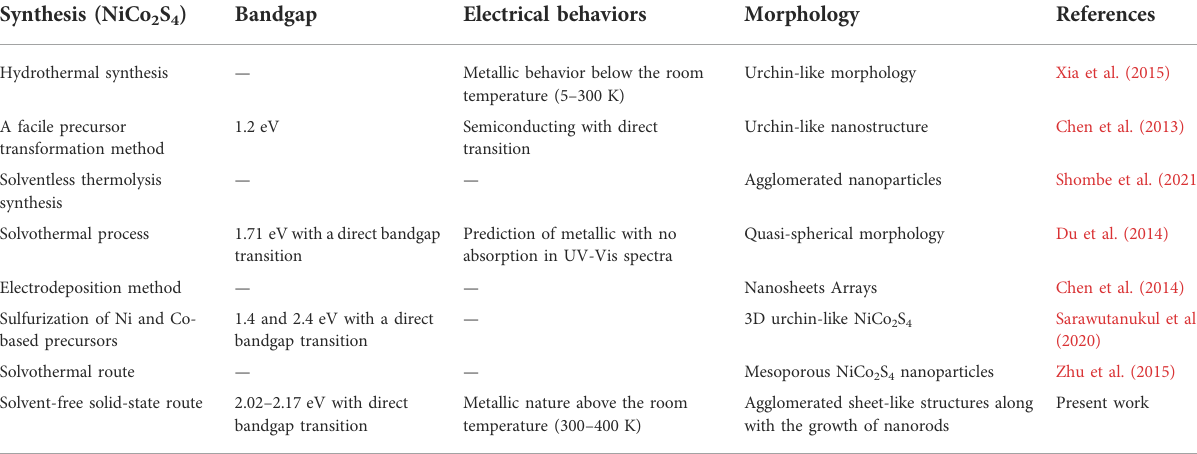
TABLE 1 Comparison of the present study of NiCo 2 S 4 with previously reported